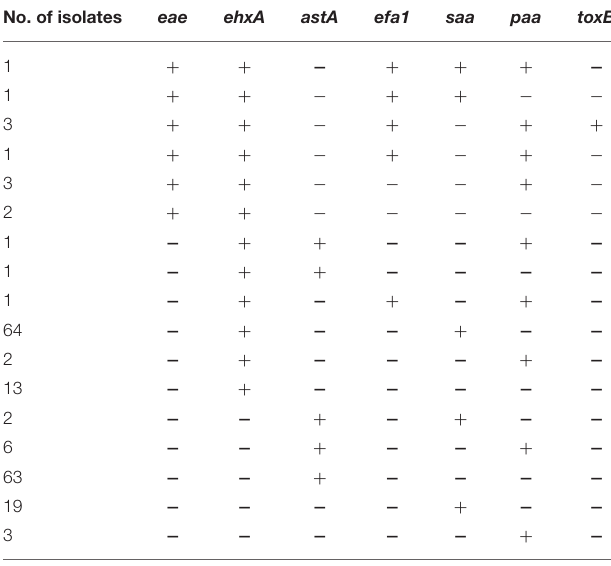
TABLE 4 | Virulence genes in non-O157 STEC isolates. No. of isolates eae ehxA astA